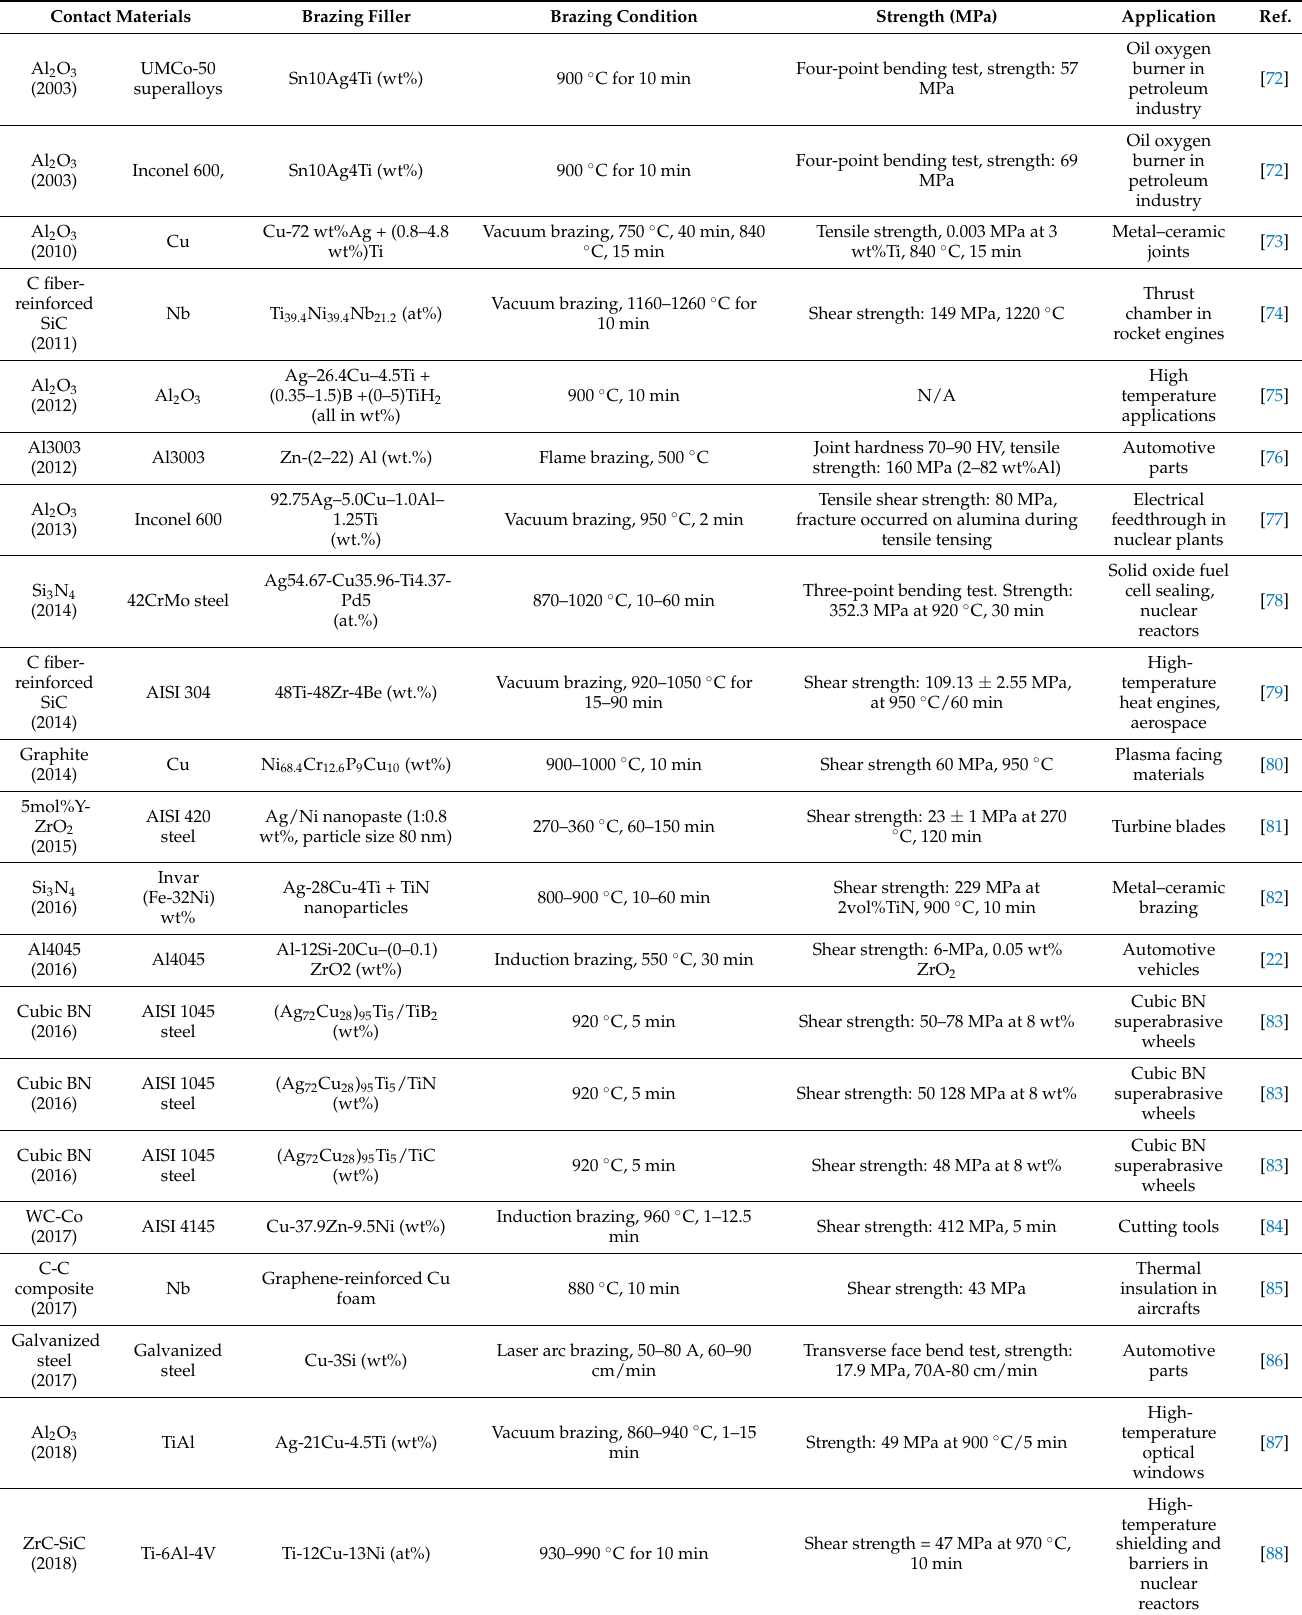
Table 3. Current trends in important brazing materials and their effect on the mechanical properties of brazed joints. Contact